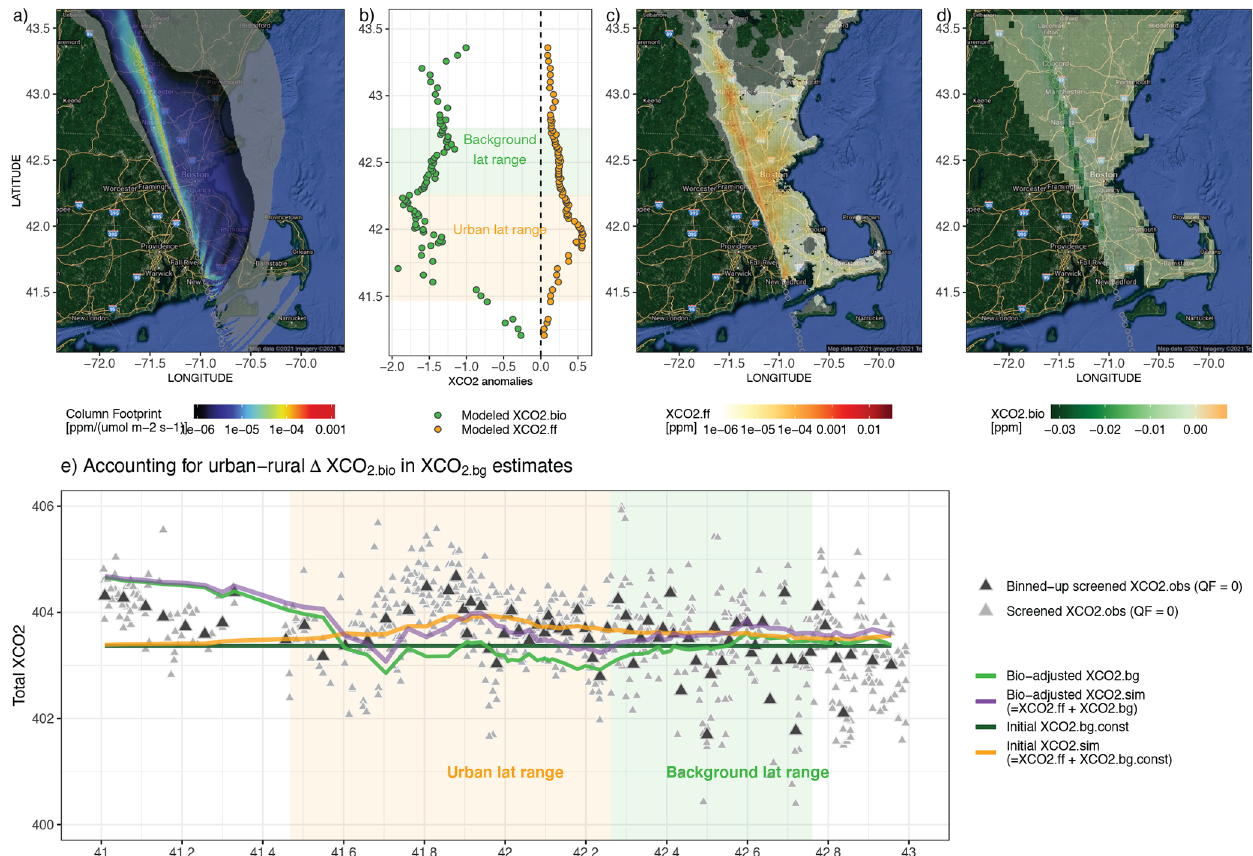
Figure 12. Demonstration of the application of SMUrF in the context of column CO 2 measurements for an OCO-2 overpass at 17:00UTC on 7 July 2018 to the west of Boston. The time-integrated column footprints [ppm/(µmolm − 2 s − 1 )] originating from dozens of receptor locations have been integrated along latitude (a) . The wind was blowing from the urban center of Boston onto the satellite swath. (c– d) Spatially explicit XCO 2 contributions from ODIAC-based FFCO 2 and SMUrF-based NEE (XCO 2 . ff and XCO 2 . bio in ppm). Note that the spatial footprint (a) and the spatial contribution of XCO 2 . ff (c) are plotted in log 10 scale, with small values < 10 − 6 ppm/(µmolm − 2 s − 1 ) displayed in light gray. The upwind contributions with respect to a column receptor are summed up, which leads to the total modeled XCO 2 . ff or XCO 2 . bio anomalies per receptor (orange or green dots in panel b ). Light orange and green ribbons indicate the urban-enhanced and background latitude range, following the approach in Wu et al. (2018) (also demonstrated in Fig. S13). Note that the underlying hybrid maps in panels (a) , (c) , and (d) were generated using the ggmap R library with Google Maps (Map data © 2021 Imagery © 2021 TerraMetrics). (e) An example of incorporating (cid:49) XCO 2 . bio into the background estimates. The screened observed XCO 2 values (QF = 0; gray triangles) are averaged in bins to match the locations of X-STILT receptors (black triangles). The dark and light green lines indicate the constant and bio-adjusted XCO 2 background. Differences between two XCO 2 . bg values indicate the (cid:49) XCO 2 . bio , which is calculated by subtracting the mean XCO 2 . bio within the rural range from all the simulated XCO 2 . bio values along the swath. The FFCO 2 enhancements are further added to the two different background values to arrive at the total modeled XCO 2 (orange and purple